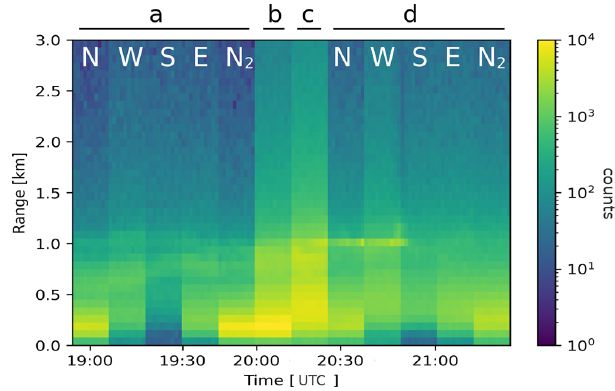
Figure 14. Validation measurement session (2 February 2021). Telecover (a) and full telescope measurement in the non-optimized position (b) and in the optimized position ( d and c , respectively).